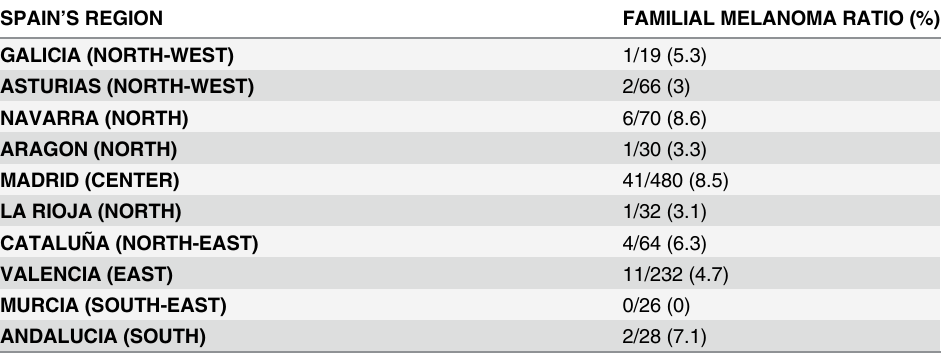
Table 1. Distribution of familial melanoma across different regions in